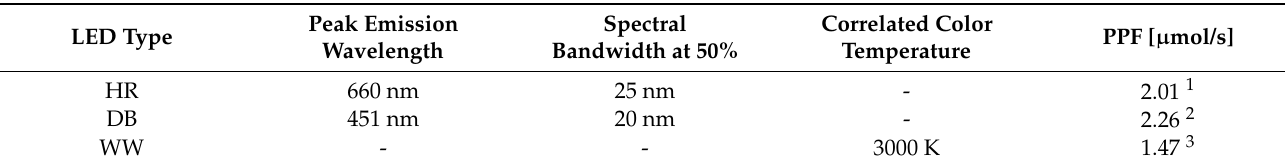
Table 2. Main opto-electrical features of the considered single LED as result by combining data reported in datasheets and off-line